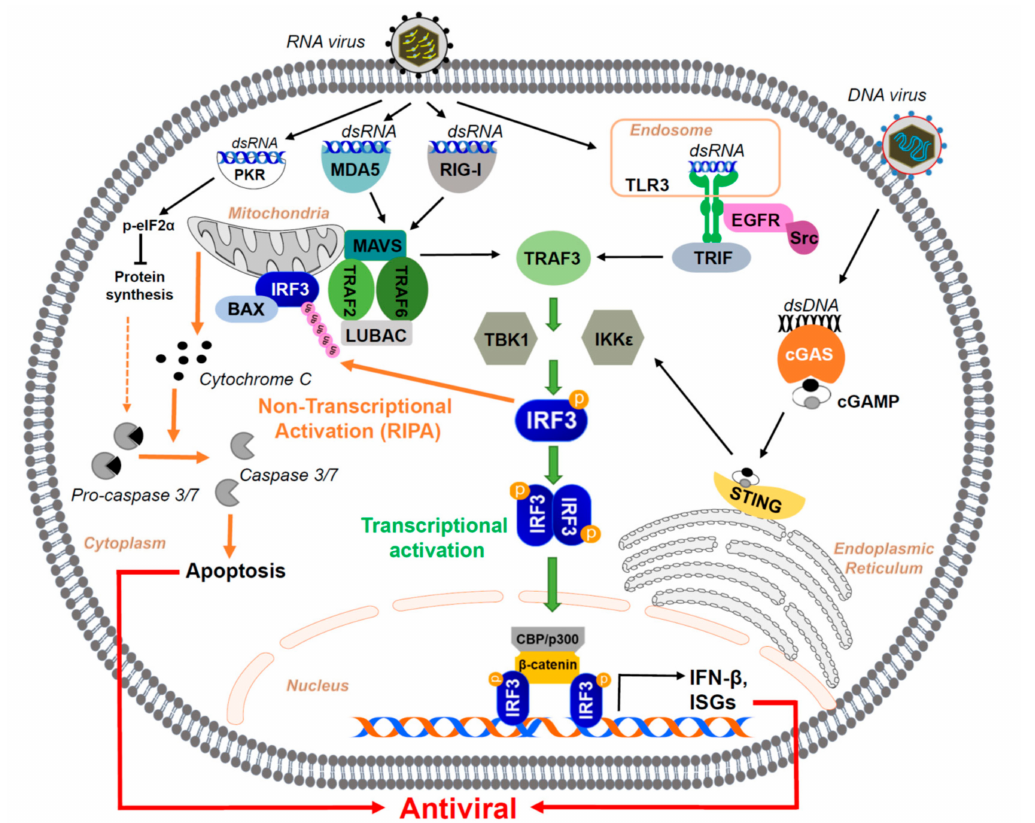
Figure 1. The transcriptional and non-transcriptional activation of IRF3 by virus-activated signaling pathways lead to host antiviral response. The PRRs, e.g., TLR3, RIG-I, MDA-5, and cGAS, present at different cellular locations, recognize the viral nucleic acids (RNA or DNA) upon their entry into the host cell. In the transcriptional activation of IRF3, the PRR-mediated signaling pathways activate the downstream kinases, TBK1 and IKK ε , and directly phosphorylate the cytosolic IRF3. The phosphorylated IRF3 translocates to the nucleus to transcribe the antiviral genes, e.g., IFN β and ISG. In the non-transcriptional pathway, IRF3 gets activated by ubiquitination and translocates to the mitochondria to activate the intrinsic caspases, leading to apoptotic cell death. The transcriptional and non-transcriptional pathways of IRF3 contribute to the overall antiviral response of the host. A dsRNA-binding protein PKR can also trigger cellular apoptosis by activating eIF2 α , which inhibits protein